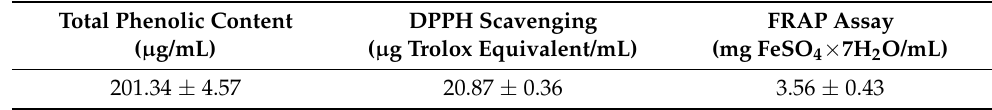
Table 3. Total phenolic content and antioxidant capacity of the PE